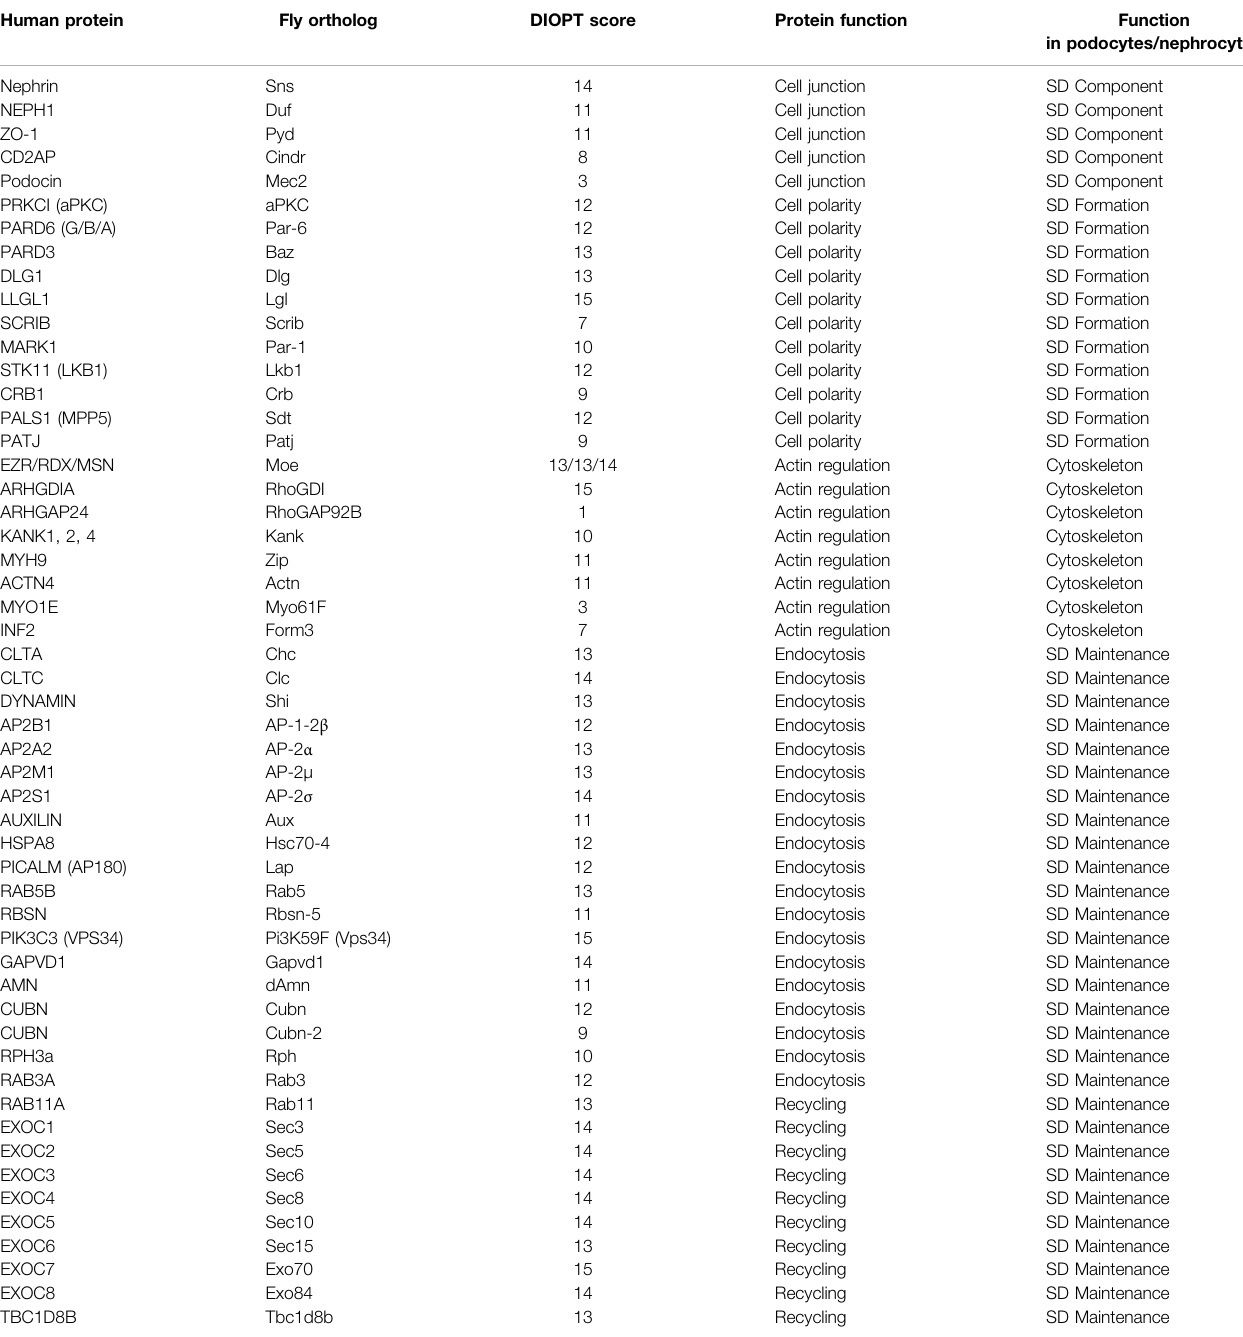
TABLE 1 | Essential slit diaphragm proteins. Human